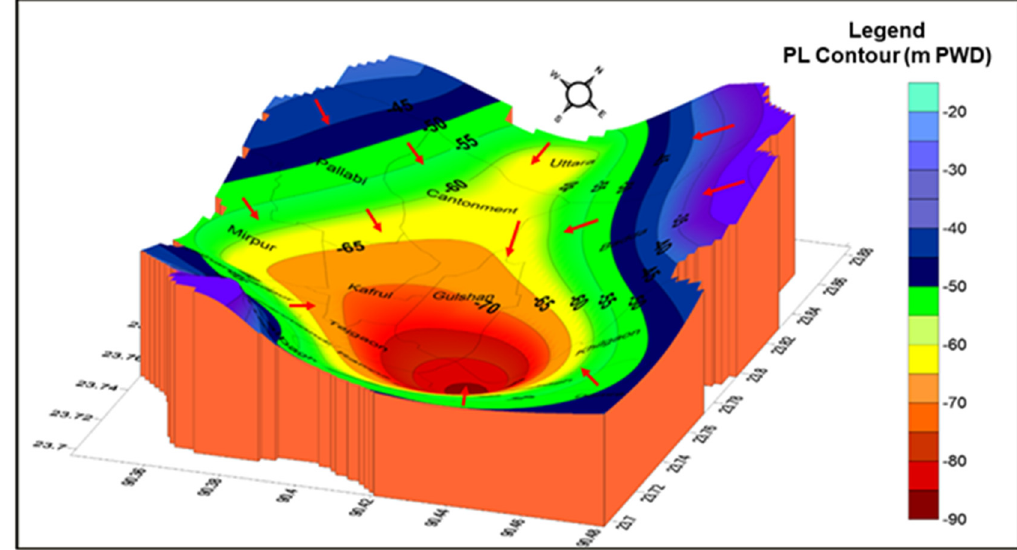
Figure 15. Three-dimensional PL elevation model with water flow directions for 2018 in UDA in Dhaka city.